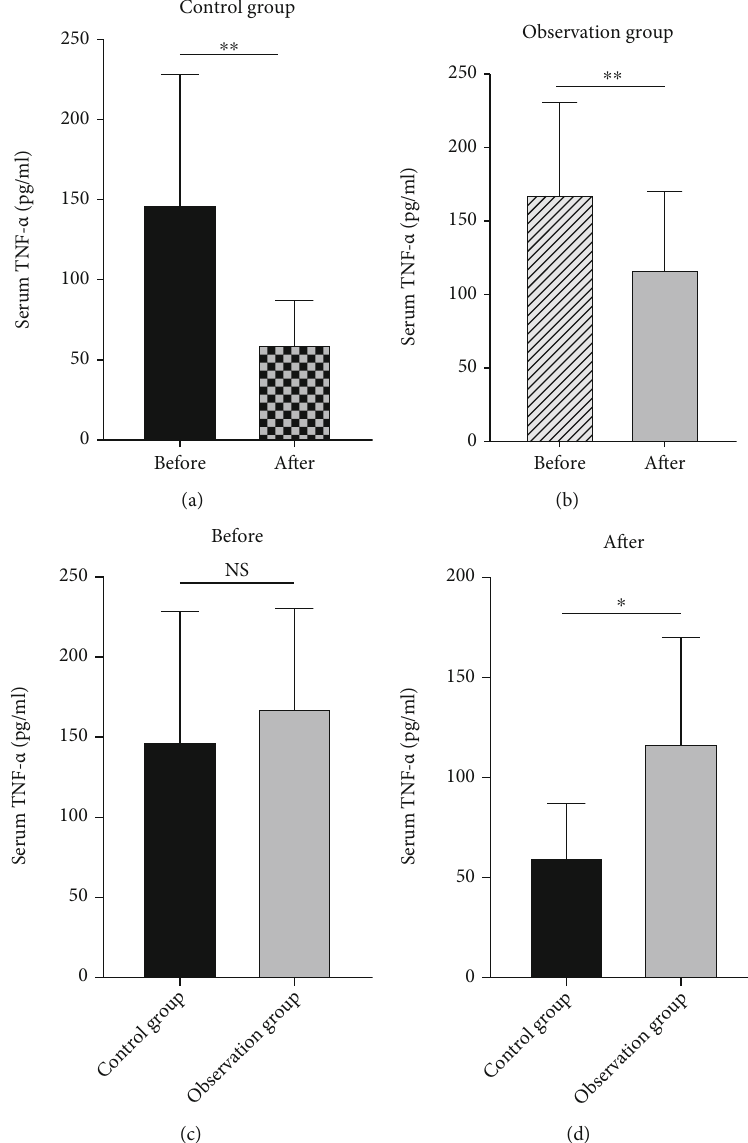
Figure 3: Analyze the changes of TNF- α protein expression before and after treatment in the two groups, observation group (a) and control group (b). Reanalysis of the protein expression level of TNF- α before treatment between the two groups of patients was not statistically signi fi cant, proving that the two are comparable (c). Comparing the TNF- α levels of the two groups of patients after treatment, it was found that the protein expression level of the observation group was lower than that of the control group, and the di ff erence was statistically signi fi cant (d) ( n = 30 , ∗∗ p < 0 : 01 , ∗ p < 0 : 05 , NS: no signi fi